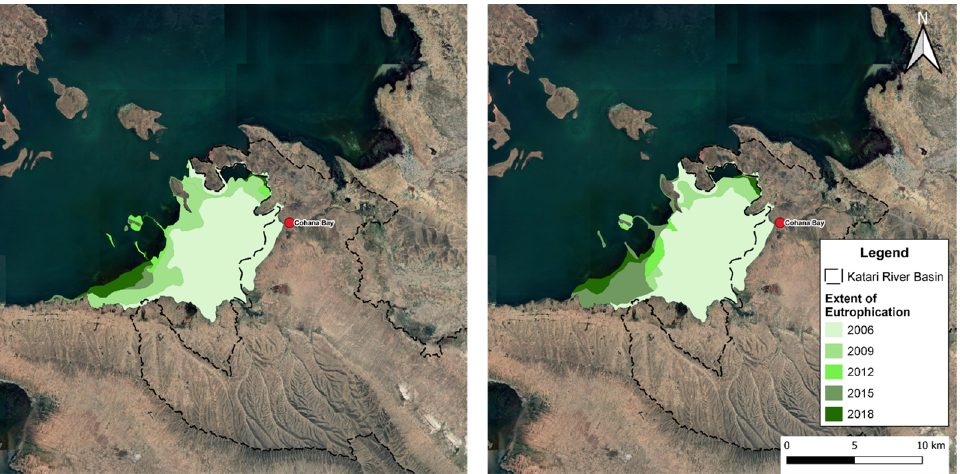
Figure 5. Increase of eutrophication extent in Lake Titicaca measured by NDVI for the study period. Left: dry season, right: wet season .